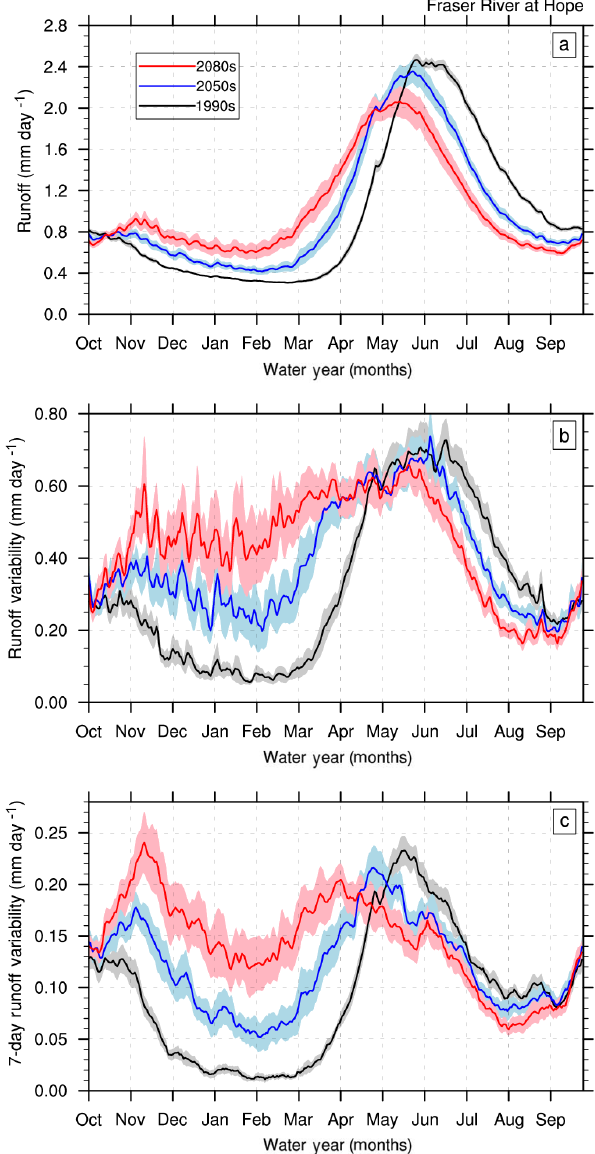
Figure 8. CMIP5-VIC-simulated daily runoff (normalized dis- charge) mean (a) , variability (b) and 7-day variability (c) for the Fraser River at Hope. Black, blue and red curves represent the MME mean for the 1990s, 2050s and 2080s, respectively. Shading repre- sents inter-model spread, as indicated by a 5%–95% model range.